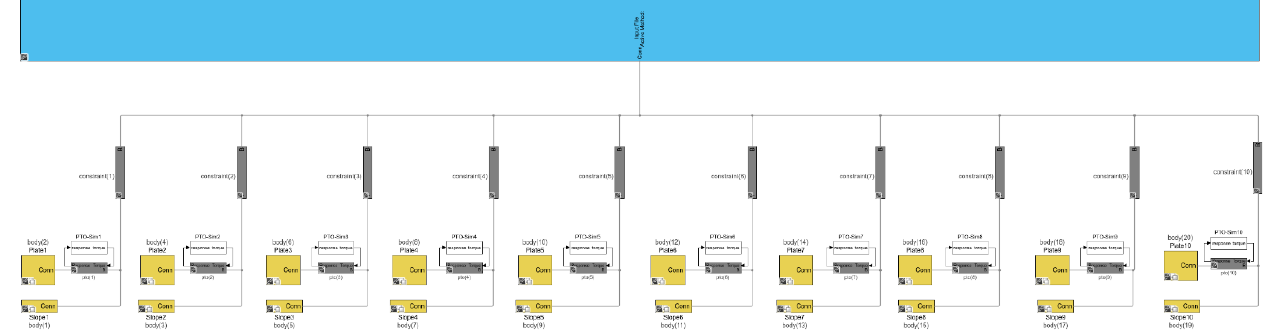
𝑆𝑆 𝑑𝑑 . The interaction between waves and floating